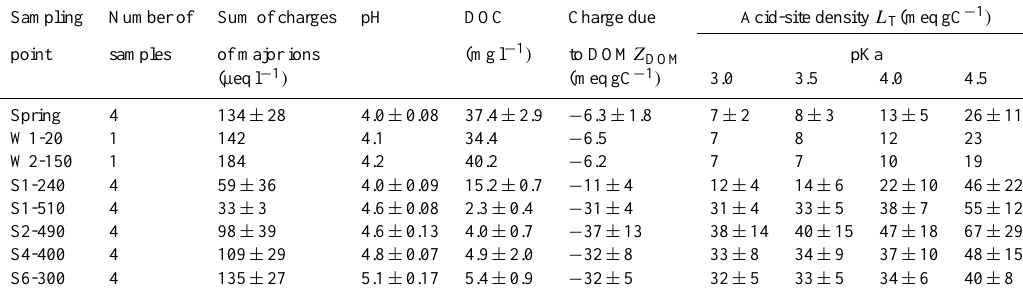
Table 6. Calculated charge due to DOM and acid site density for various pKa. Sampling Number of Sum of charges pH point samples of major